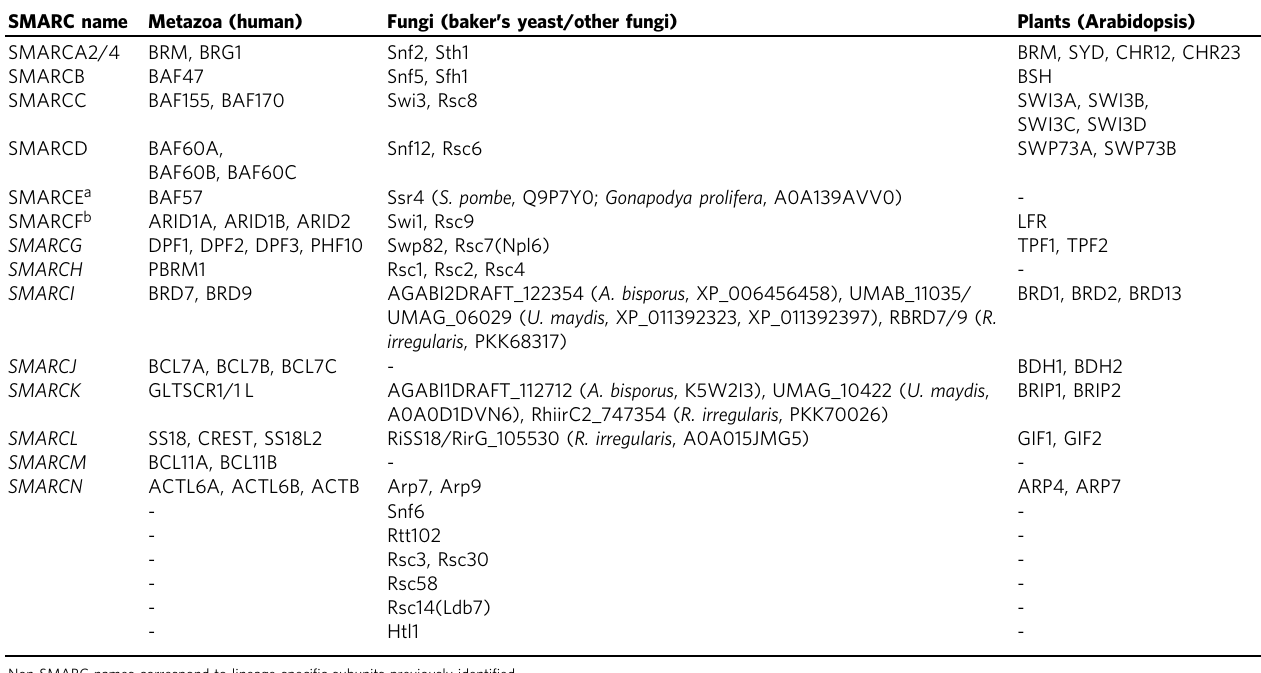
Non-SMARC names correspond to lineage-speci fi c subunits previously identi fi ed. New SMARC names assigned by the HUGO Gene Nomenclature Committee are indicated in italics. a SMARCE is an animal-speci fi c subunit with already established SMARC nomenclature. b SMARCF naming for ARID-type subunits has been employed in a limited number of databases and articles. Allnamescorrespond toreferencespecies: humanforMetazoa, Saccharomycescerevisiae forFungi,andArabidopsisforPlants.Subunits notpresentin thereference speciesbutpresentinthe lineageare